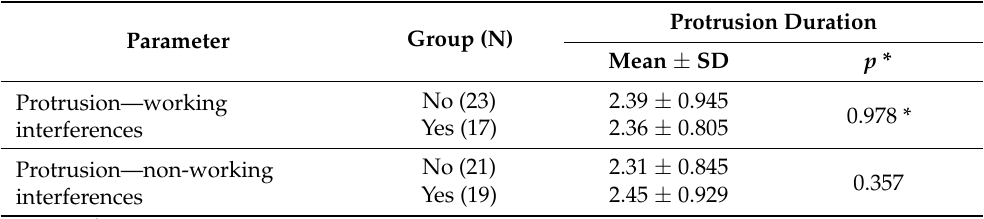
Table 8. The duration of the protrusion movement according to the presence or absence of interfer- ences (seconds).